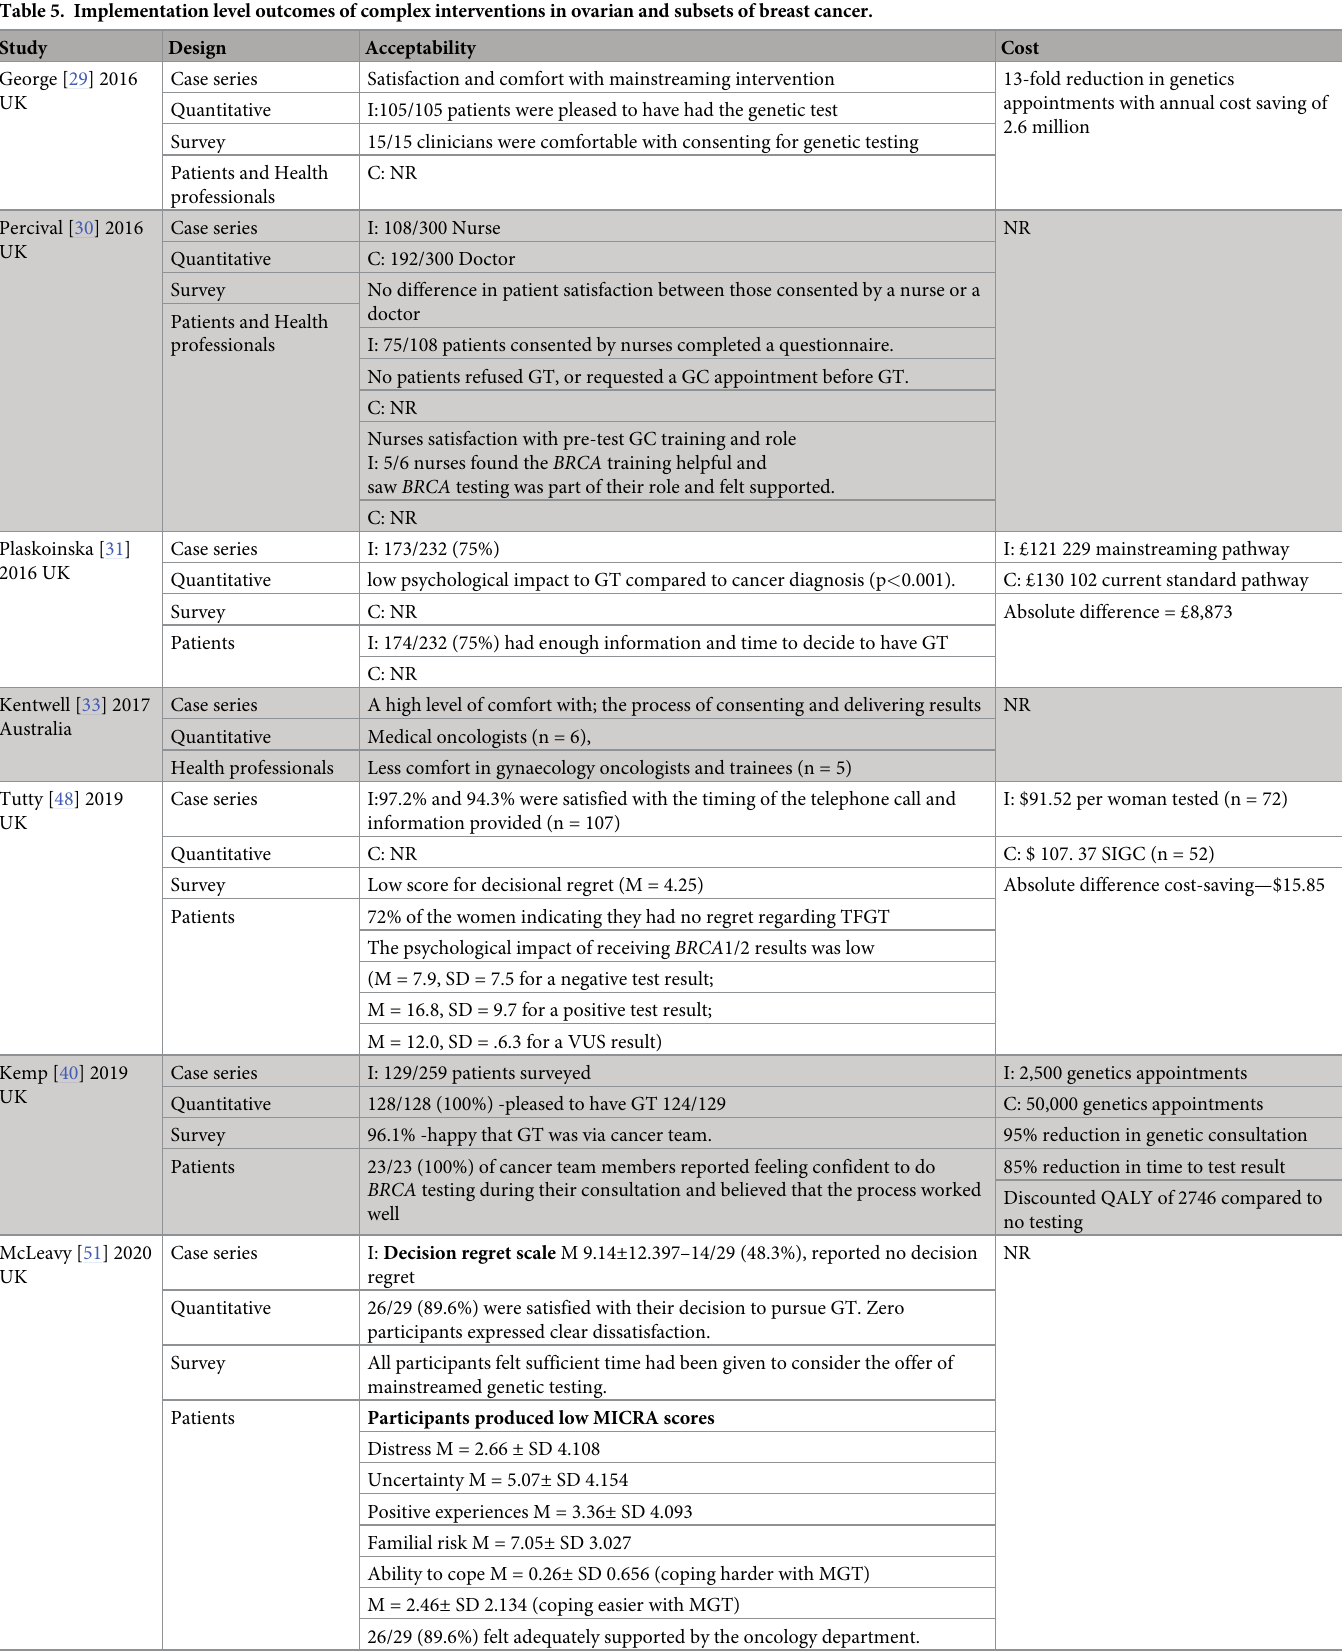
Table 5. Implementation level outcomes of complex interventions in ovarian and subsets of breast